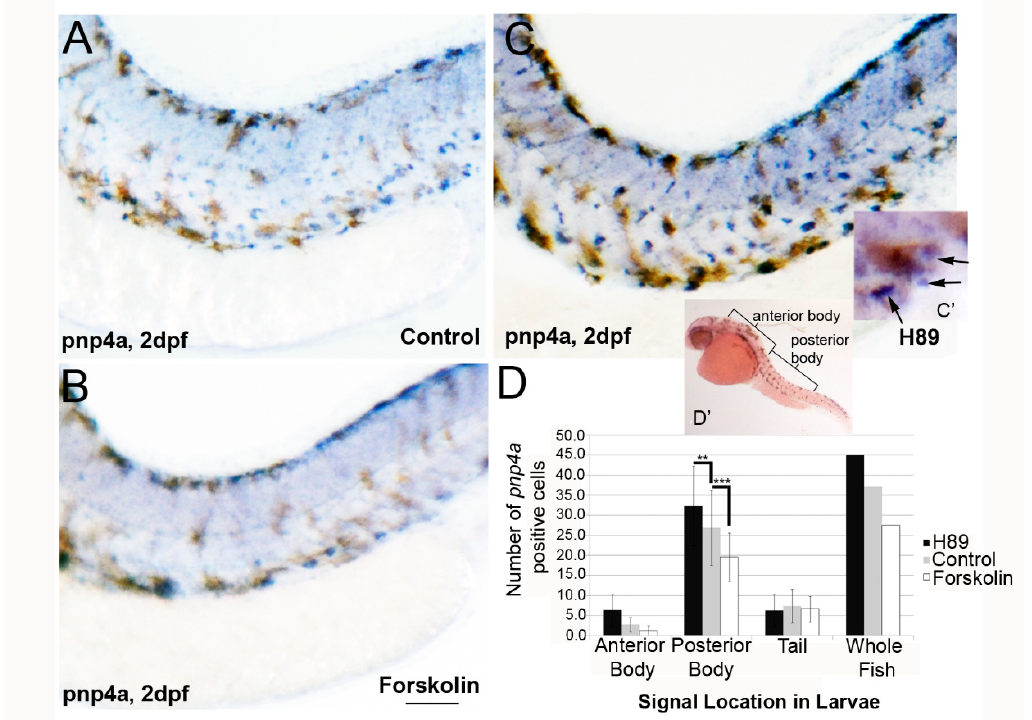
Figure 3. Forskolin treatment reduces iridoblast marker pnp4a expression. ( A – C ) Lateral brightfield images of larvae at 2 dpf processed for in situ hybridization using pnp4a probes, following treatment with 0.1% DMSO ( A ), 5 µM forskolin ( B ), or 25 µM H-89 ( C ) in embryo media. Activation of adenylyl cyclase (and PKA signaling) reduces the levels of pnp4a expression, whereas inhibition of PKA has the converse effect (increased pnp4a expression). Scale bar = 200 um andapplies to all images. ( C’ ) Representative image with black arrows showing blue/purple pnp4+ cells included in panel D quantification. Brown melanophores were not included in counts. ( D ) Quantification of pnp4a+ cells confirms a significant reduction and increase in the number of pnp4a+ cells following forskolin and H-89 treatment, respectively (** p < 0.01 and *** p < 0.0001 via two-way ANOVA and Bonferonni multiple comparison analysis). ( D’ ) The quantified regions are labeled.